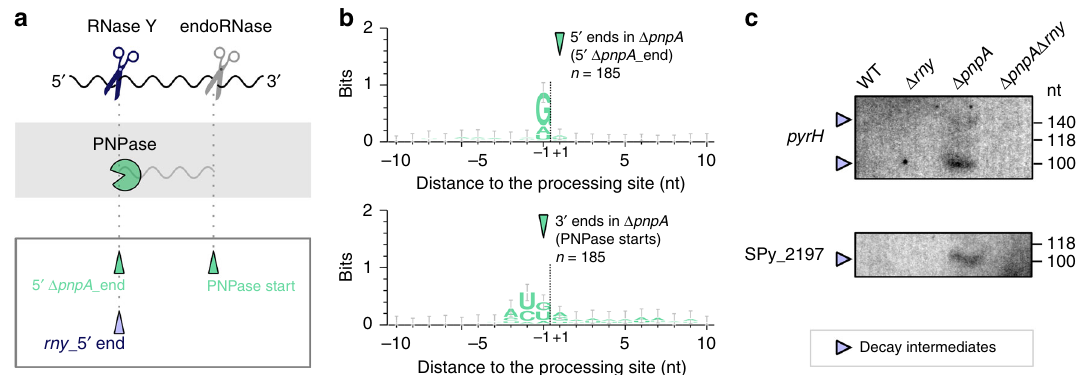
Fig. 7 RNase Y produces decay intermediates degraded by PNPase. a Schematic representation of decay intermediates generated by RNase Y (blue scissors) and rapidly degraded by PNPase ( ‘ pacman ’ symbol). RNase Y produced the decay intermediate 5 ′ end, which was identi fi ed as an RNA 5 ′ end that was more abundant in the Δ pnpA strain than in the WT strain. The decay intermediate 3 ′ end, corresponding to the PNPase trimming start position, was probably produced by an unidenti fi ed endoRNase (grey scissors). b Sequence conservation around the 5 ′ ends (5 ′ pnpA _ends) and 3 ′ ends (PNPase starts) of the decay intermediate from the 185 decay fragments previously identi fi ed, present in the Δ pnpA strain and not in the WT strain. c Northern blot analyses of decay intermediates (in pyrH and SPy_2197) in the WT, Δ rny , Δ pnpA and Δ pnpA Δ rny strains. The RNase Y-generated fragments degraded by PNPase (purple arrows) are indicated. Shown are the results of one representative northern blot analysis ( n = 3). The full blots, loading controls, RNA sequencing-based RNA end pro fi le with the detected 5 ′ and/or 3 ′ rny _ends, and trimming start positions are shown in Supplementary Fig. 6 and the source data are provided as a Source Data fi le.